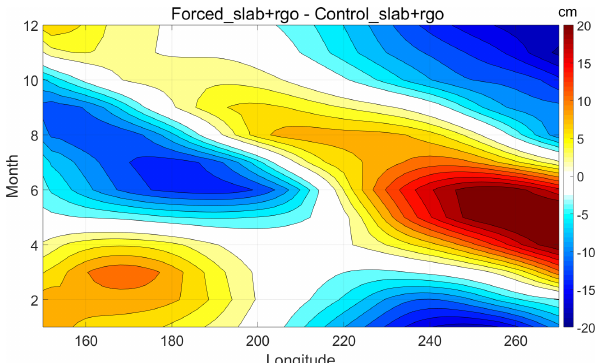
Figure 11. Equatorial Pacific Ocean (2 ◦ S–2 ◦ N, 150–270 ◦ E) de-meaned thermocline depth anomalies seasonal cycle for the Forced_slab + rgo experiment. Contour interval: